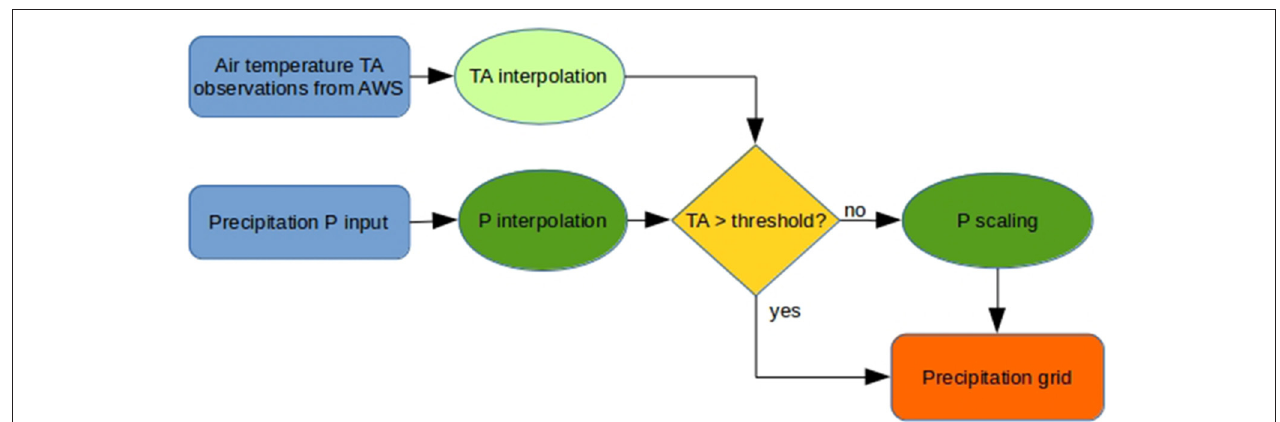
FIGURE 3 | Flow chart of the direct scaling method. An air temperature (TA) and a precipitation (P) field are generated for every time step from local time series at AWSs. Depending on the air temperature at each grid point, a decision is made if the interpolated precipitation is scaled according to the ADS data or not.